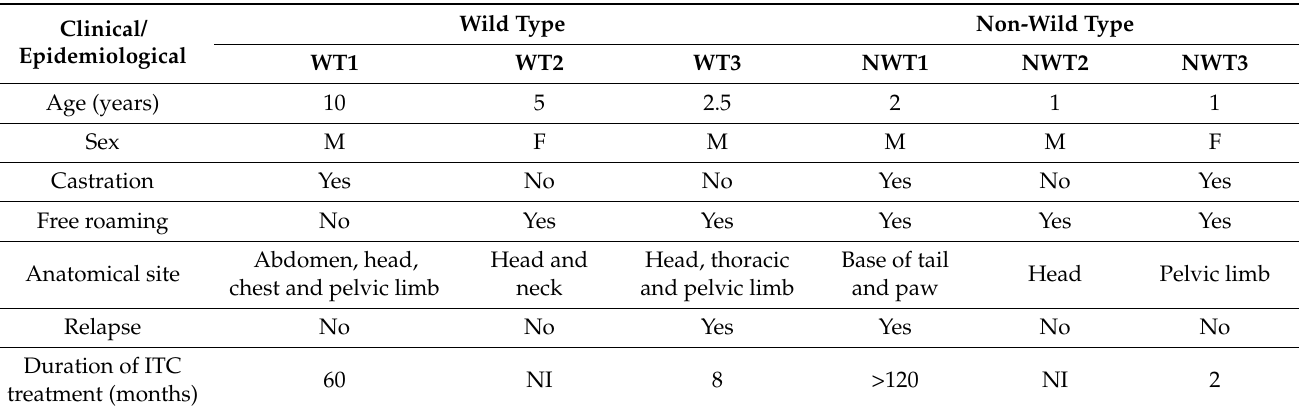
Table 1. Clinical epidemiological and laboratorial data of domestic cats infected by the six S. brasilien- sis isolates investigated in the present study.